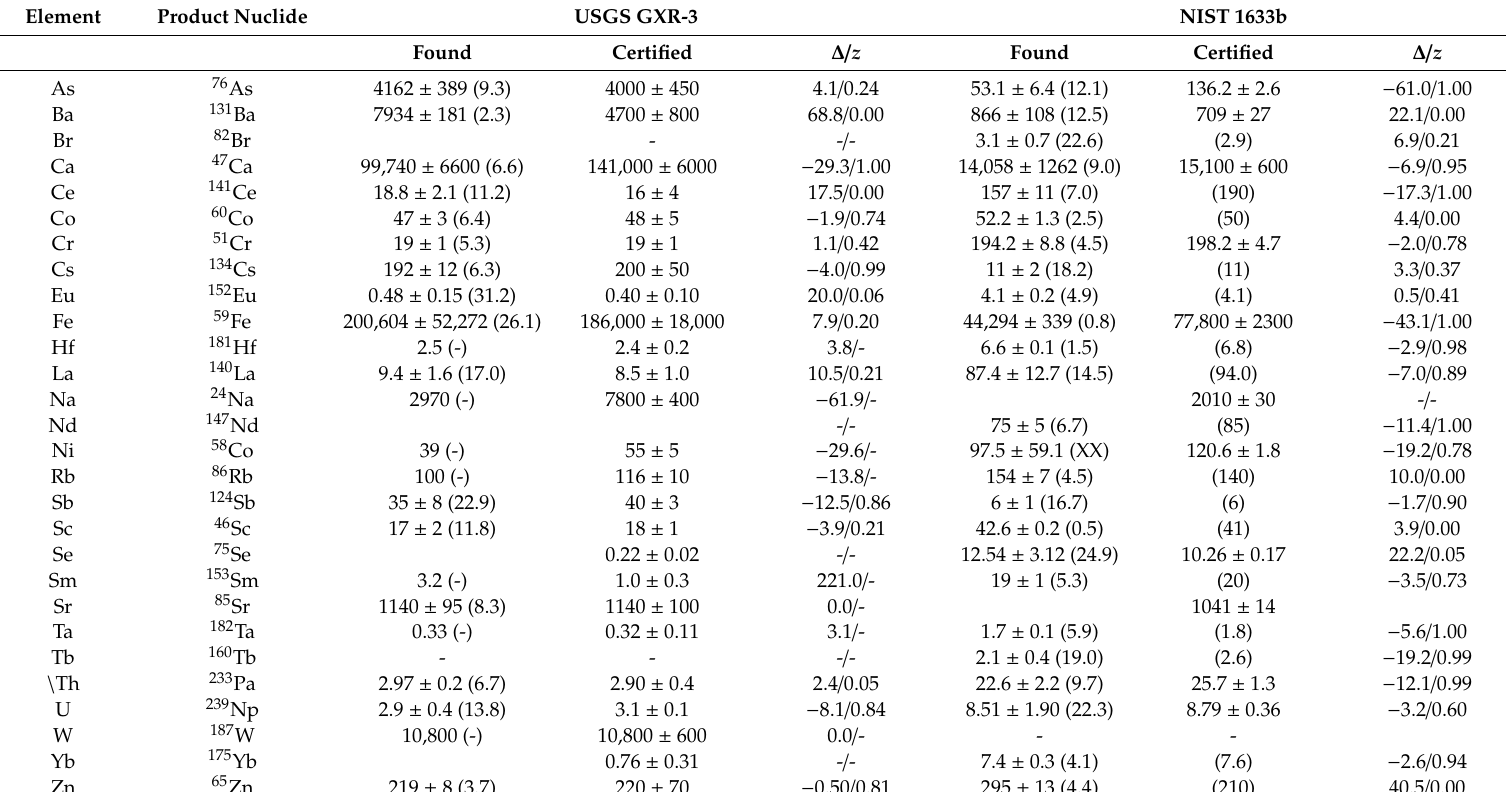
Table 2. Analytical comparison (mean ± s.d.; µ g g − 1 ) of standards USGS GRX-3 and NIST 1633b (coal fly